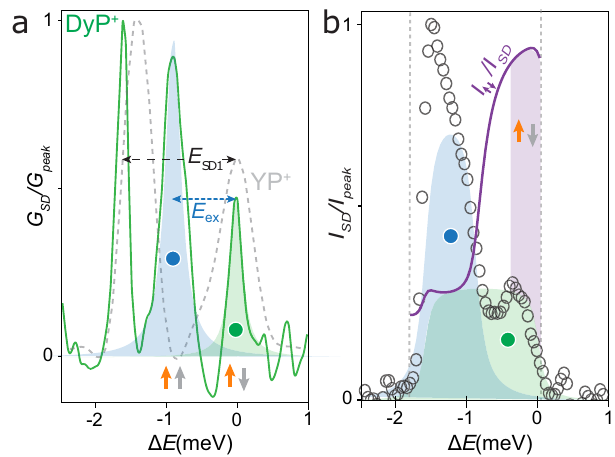
Fig. 5 Molecular polarization effect. a Zero- fi eld conductance of YP + (gray) and DyP + (green) devices at E SD = 1.5 mV vs. the energy displacement [ Δ E = β MP ( V G – V c ), where V c is the gate voltage of the Coulomb peak]. The splitting of the conductance peak induced by the exchange is highlighted in blue. Curves are scaled for their maximum peak value, for clarity. Shaded areas are Lorentzian fi ts, and marks indicate the conductance mechanism as in Fig. 3, panel d. b Contributions to the current of DyP + (gray circles) by the ferromagnetic (blue) and antiferromagnetic (green) molecular transport channels. Curves are scaled for their maximum peak value to compare to the fraction of spin-polarized electrons (violet). The violet region indicates a polarization higher than 90%, colored marks indicate the conductance mechanisms, as in Fig.